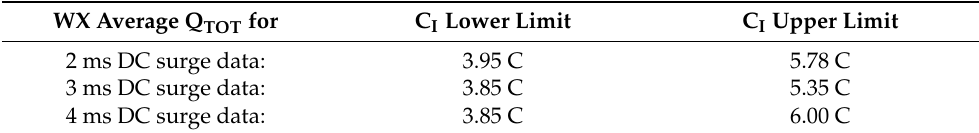
Table 6. Confidence interval limits of WX average Q TOT .